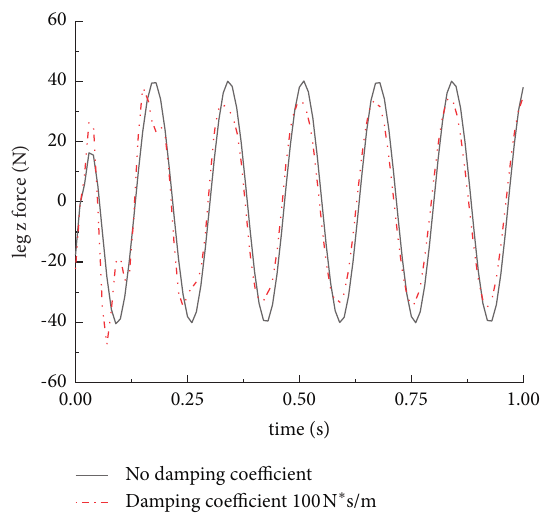
Figure 16: The force of branch 1 (constant damping coefficient 100N · s/m).